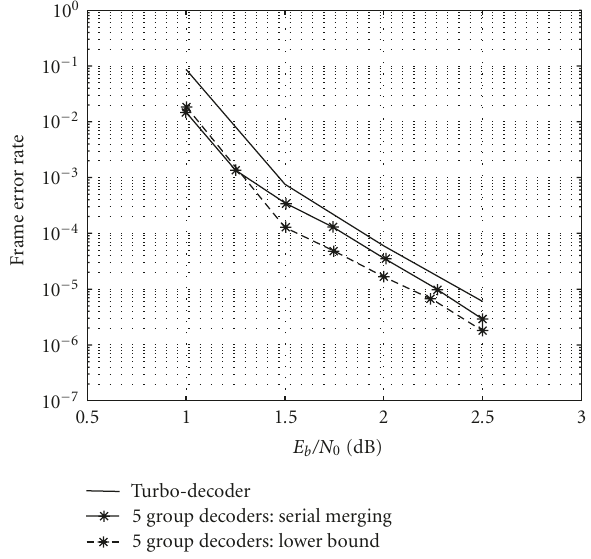
Figure 8: Decoding performance when diversity is applied to the ( R = 0 . 5, N = 3008) duobinary turbo code.